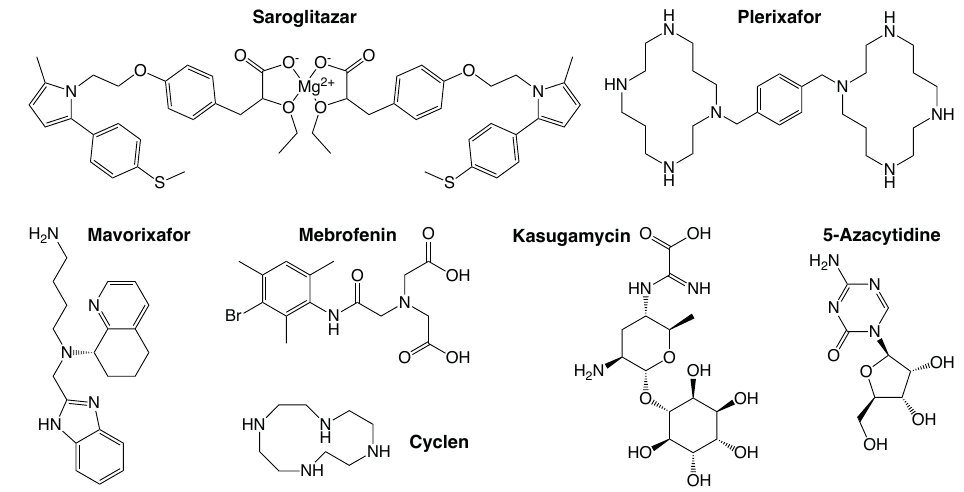
Figure 2. Chemical structures of the hits identified in the study. Note that the only the uncomplexed form of Plerixafor is shown.